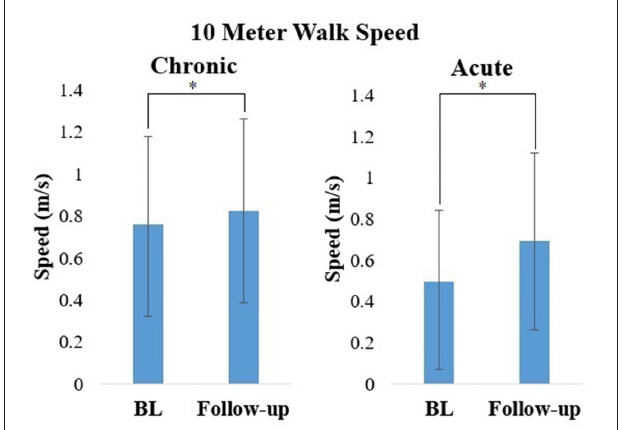
FIGURE 3 | Mean ± standard deviation of Walking speed calculated from the 10MWT during baseline (BL) and follow-up for participants in the chronic and acute stage of stroke recovery. * p < 0.05.